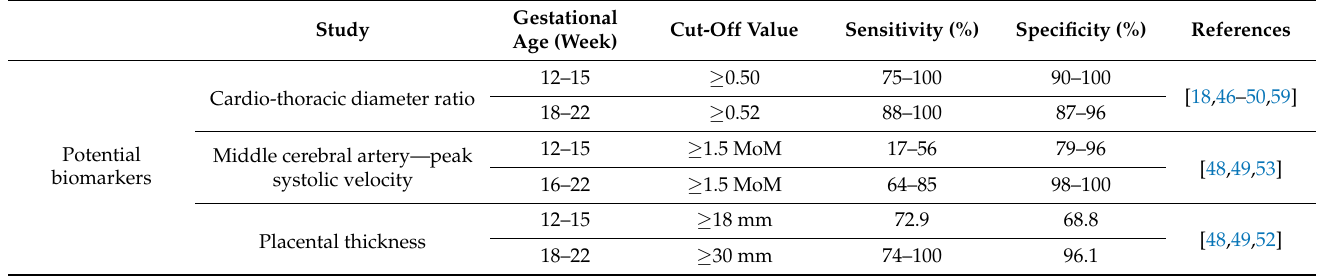
Table 1. Performance of Sonographic Markers in Predicting Fetal Hb Bart’s